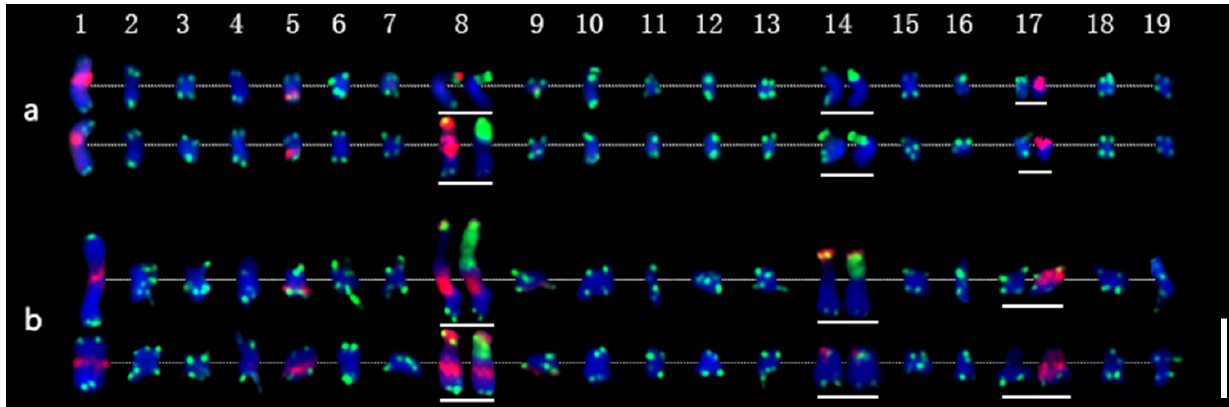
Figure 4. Molecular karyotypes of P. xiaohei and the derived doubled haploid. ( a ) Populus simonii × P. nigra ; ( b ) Doubled haploid Populus simonii × P. nigra . Chromosomes 1–19 are arranged from left to right, and homologous or homeologous chromosomes are arranged from top to bottom. In the chromosomes with white lines below, the first FISH result is shown on the left (same as in Figure 3b,e), and the second FISH result is the chromosome shown on the right (same as in Figure 3c,f). Bar = 5 μ m.